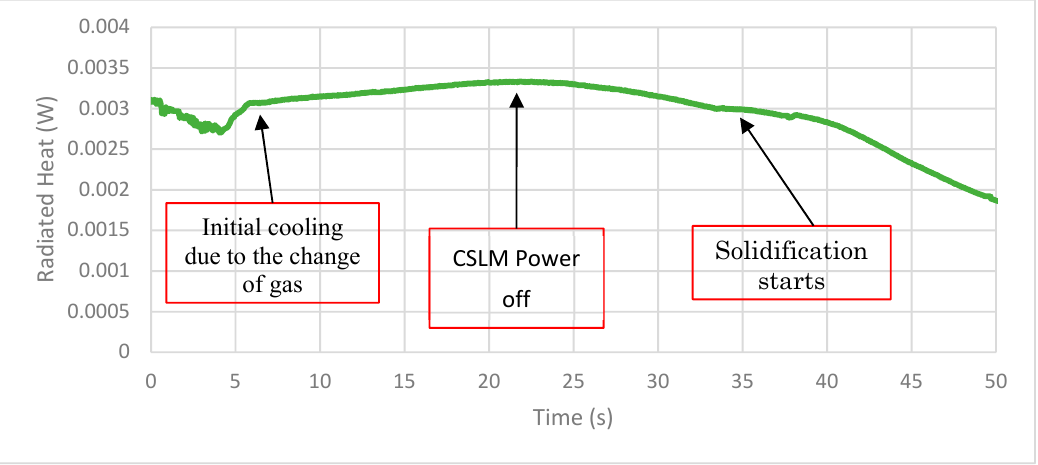
Figure 5. Radiated heat with time of the steel surface during cooling in a CO 2 atmosphere.